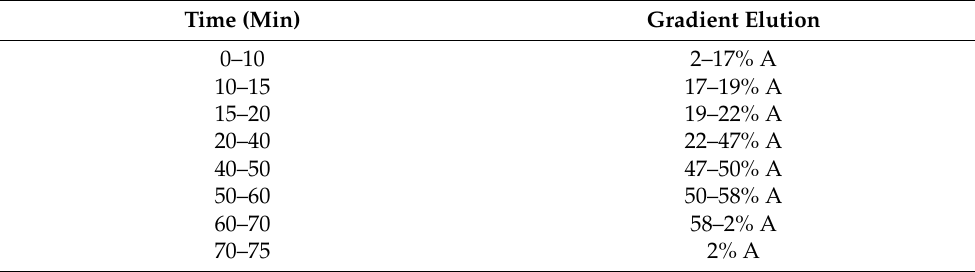
Table 1. The procedure of gradient elution.